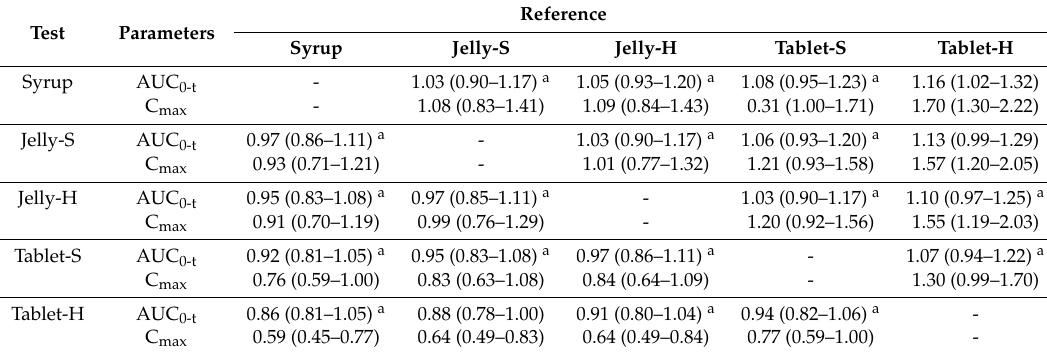
Table 8. Point estimates of mean ratio (90% confidence intervals) for